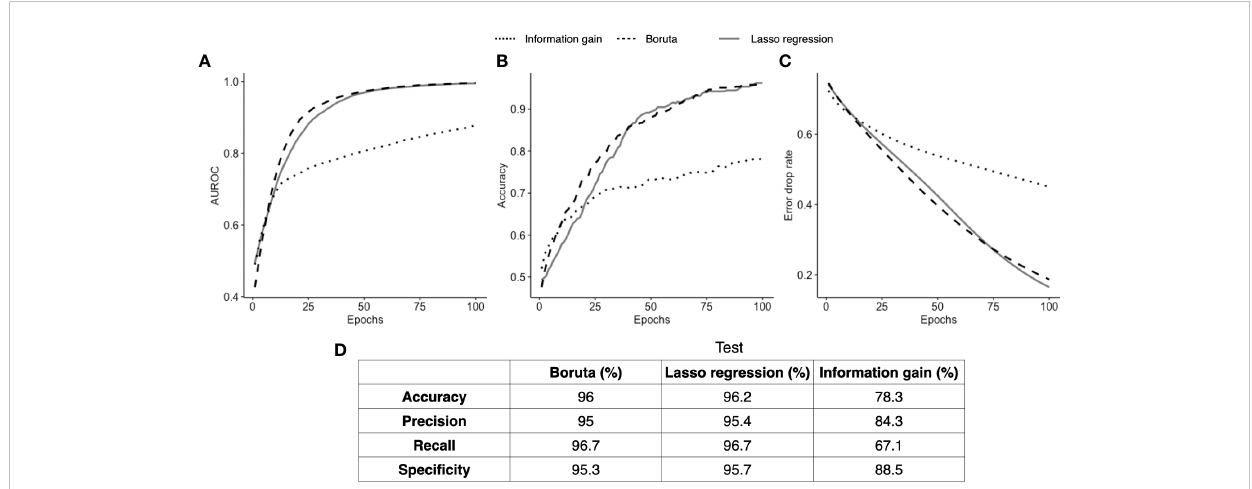
FIGURE 4 ANN classi fi cation performance. Three ANN models fed with different input biomarkers had their classi fi cation performance assessed over 100 learning epochs (Boruta in green, Lasso regression in orange, and information gain in blue). In (A) , we compare the area under the curve of the three models; in (B) we show the accuracy of each model; and in (C) we show the error drop rate (represented by binary cross entropy). Finally, in (D) , we show at the 100 th epoch the accuracy, precision, recall, and speci fi city of each